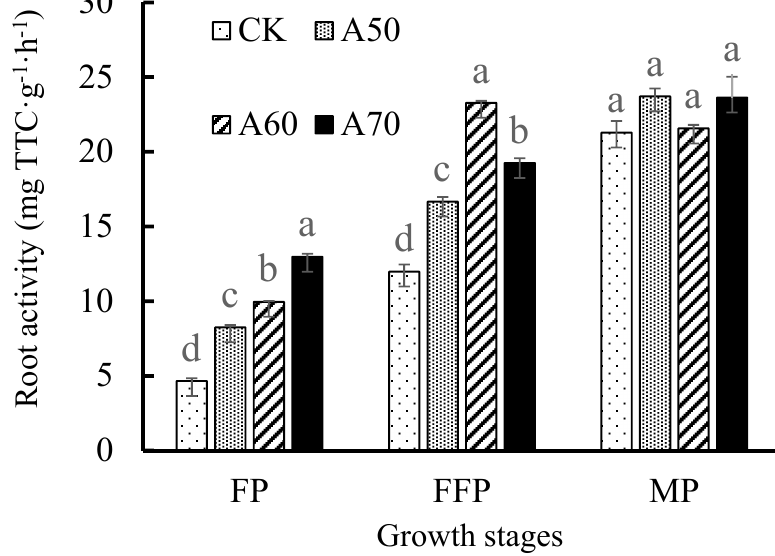
Figure 4. Tomato root activity at different growth stages under ADI. Note: Different small letters mean significant difference ( p < 0.05 ) among the different treatments in same growth stage according to Duncan test. FP was 0–50 d after tomato planting to field, FFP1 was 50–100 d after tomato planting